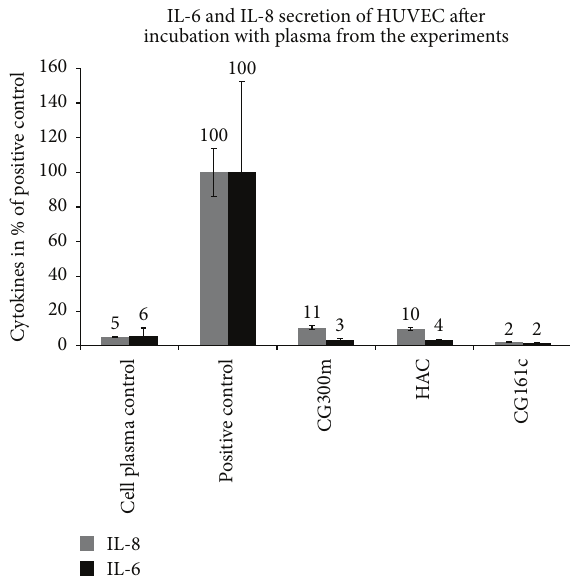
Figure 5: IL-6 and IL-8 secretion by HUVEC. The effect of cytokine removal on endothelial cell activation regarding IL-8 and IL-6 secretion after 16h incubation of HUVEC with 10% of sample plasma from the adsorption experiments. Untreated plasma (empty cartridge without adsorbent) acts as positive control. The results are shown in mean ±